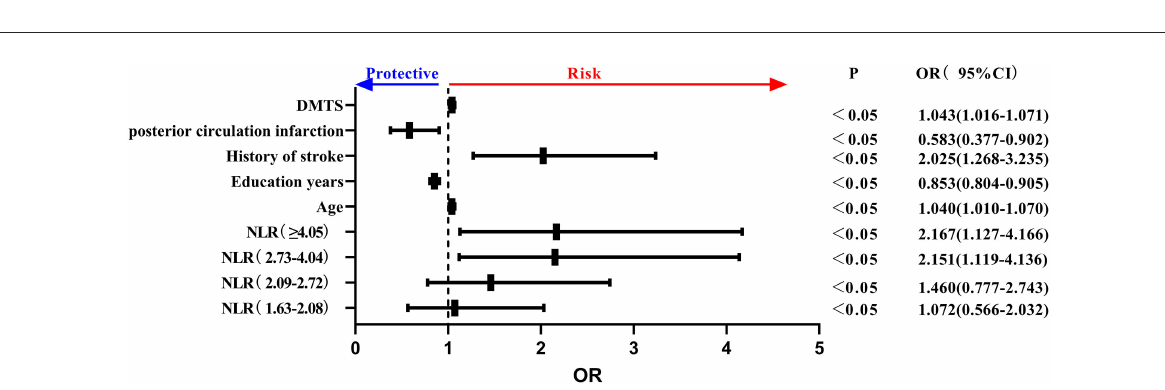
FIGURE4 Forest plot of PSCI impact factors (incorporating NLR quintiles). PSCI, post-stroke cognitive impairment; NLR, neutrophil/lymphocyte